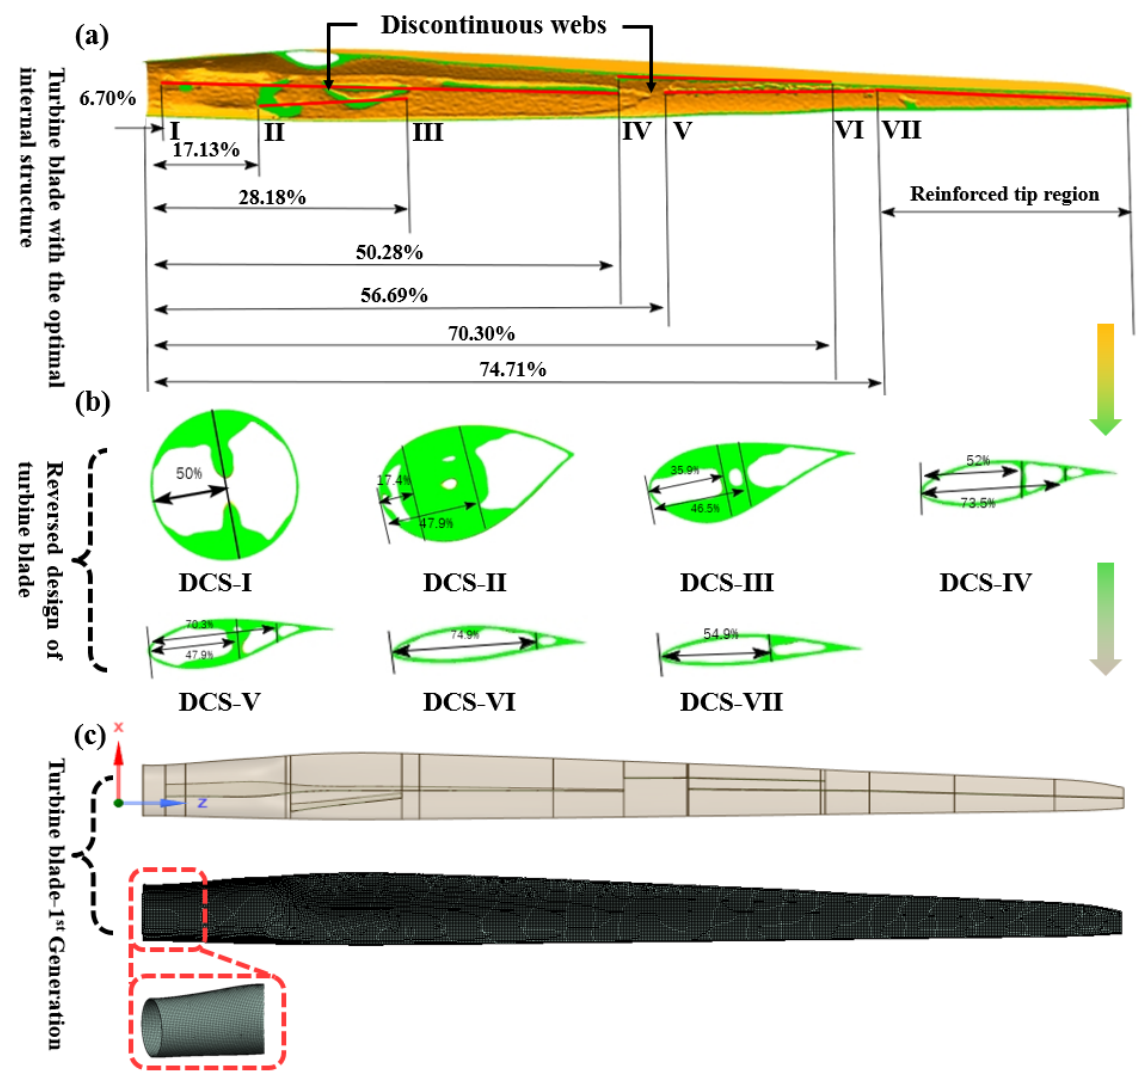
Figure 5. Reverse design of the wind turbine blade. ( a ) Turbine blade with the optimal internal structure. ( b ) Reverse design of turbine blade inspired by the topology optimization. ( c ) First generation turbine blade.